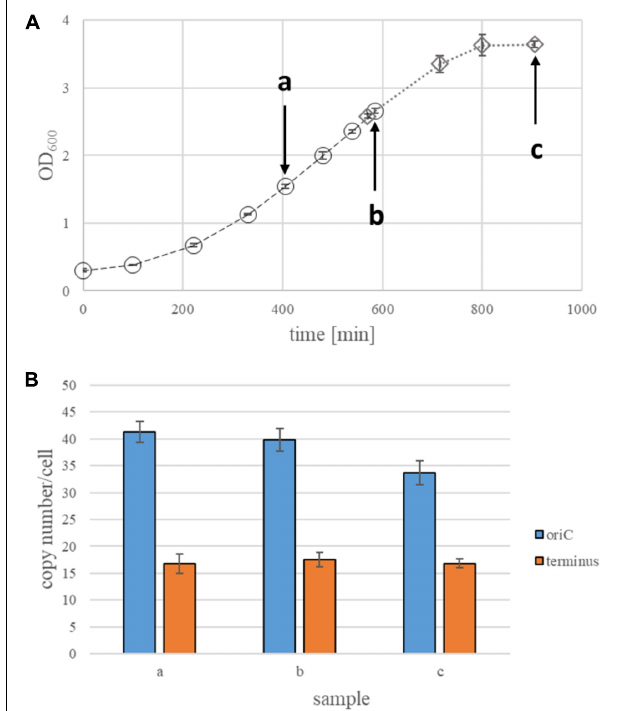
FIGURE 5 | Quantification of origin and terminus copy numbers in strain Zm6N under aerobic conditions. (A) Growth curves of Zm6N strain under aerobic conditions. Average OD 600 values of three biological replicates and their standard deviations are shown. Two sets of experiments (three biological replicates each) were performed, because in the first set of experiments the results in stationary phase did not meet the quality criteria (see different symbols and different dashed lines). Arrows indicate time points of collecting samples for quantification of genomic copy numbers. (B) Origin and termini copy numbers in aerobically growing Zm6N. Samples at an early stationary phase were collected about 1 h after the culture reached a plateau of its growth curve. All time points at growth phase are three biological replicates, while two biological replicates at an early stationary phase and 5 biological replicates were made for a late stationary phase. Standard deviations (STD) are presented as error bars.